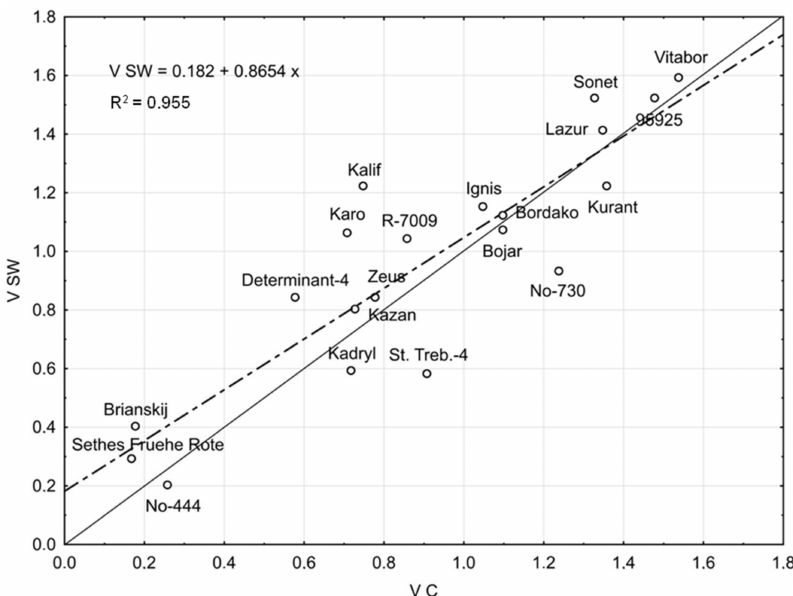
Figure 1. Seed germination vigour (V) of Lupinus angustifolius lines/cultivars at 7 ◦ C under smoke water (SW) treatment (V SW) vs. control (V C). Dashed line indicates the regression line. Solid line separates lines/cultivars according to their response to SW: points lying above and below the line correspond to more- and less-responsive line/cultivars,